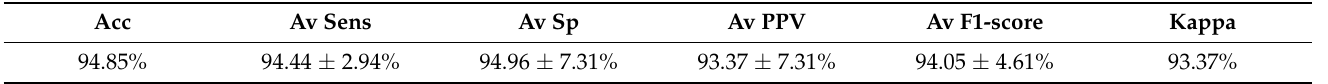
Table 14. Overall performance of the two models through Acc, averages of Sens, Sp, PPV, and F1-score, and